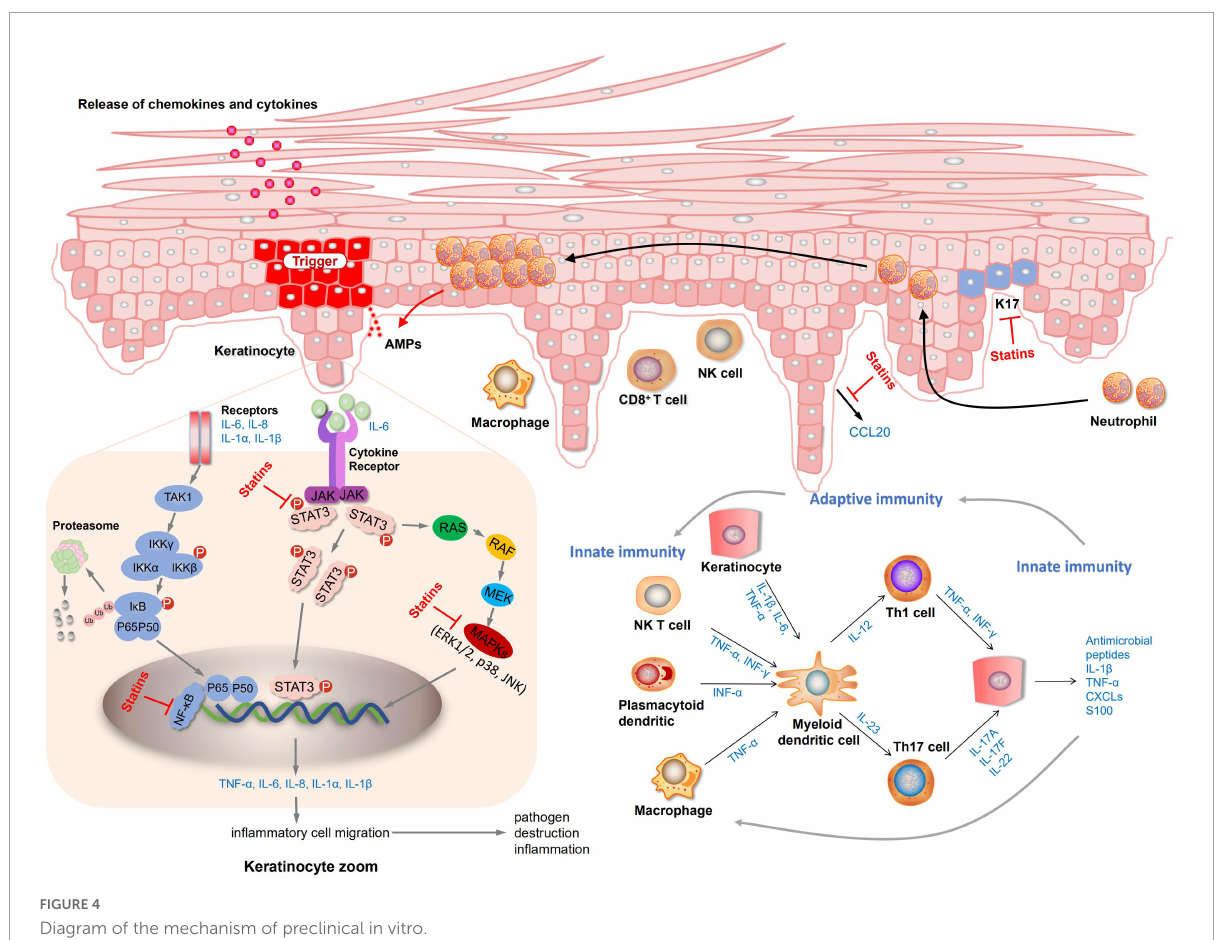
FIGURE4 Diagram of the mechanism of preclinical in